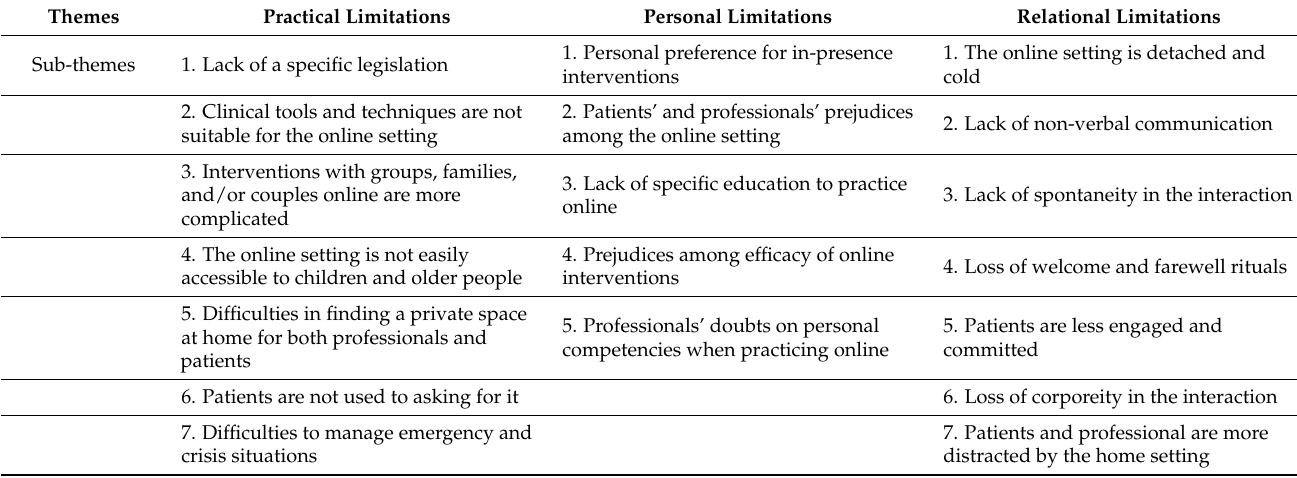
Table 3. Themes and subthemes identified analyzing the responses to the open-ended question regarding the motivations reported by the professionals who have not practiced online before the COVID-19